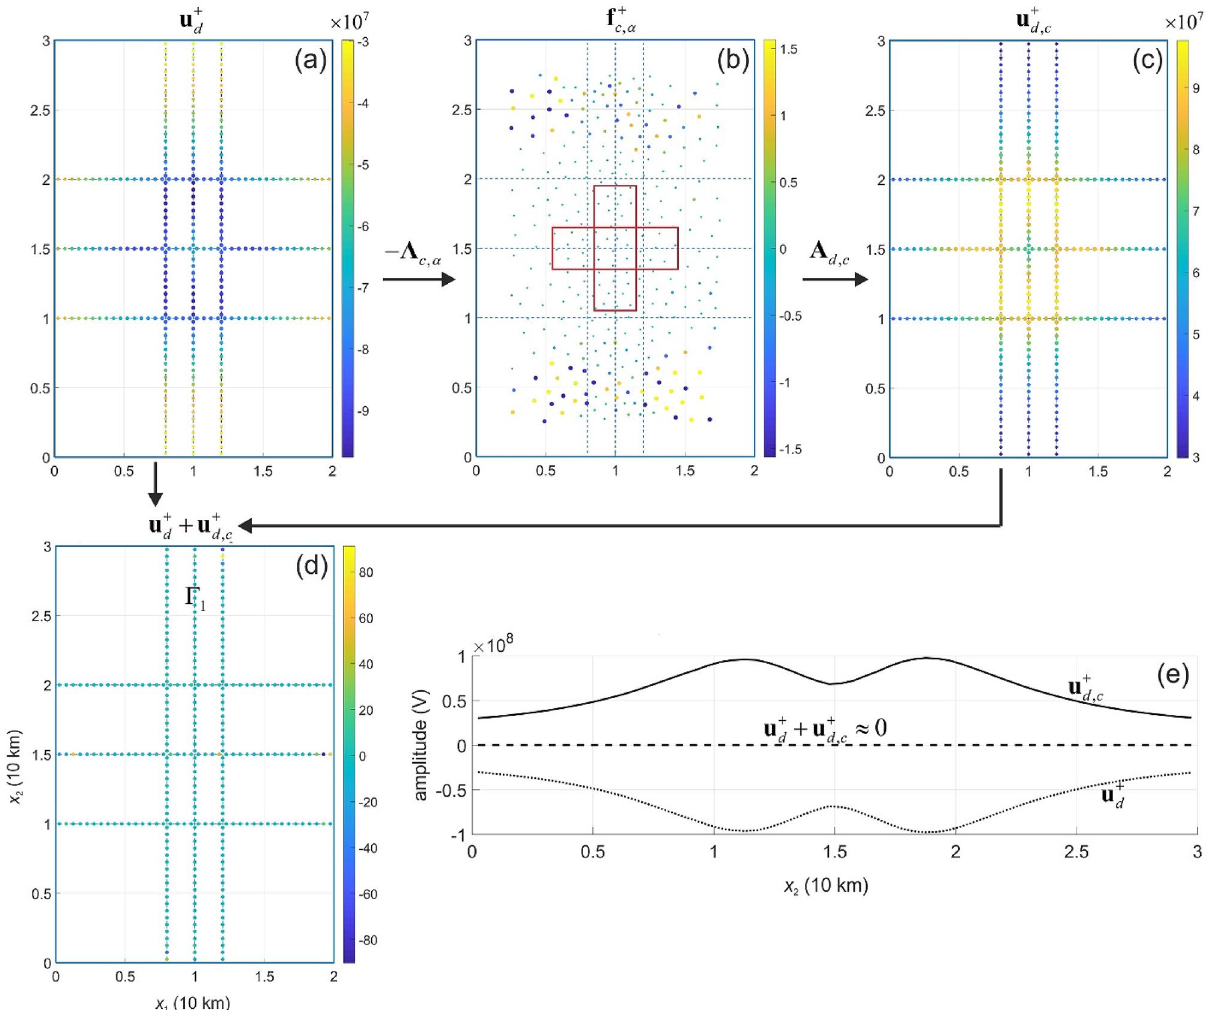
Figure 4. Active cloaking of the electric potential u + d on Ŵ ( a ) generated by the current source density f + . Using Eq. (13) the cloaking devise is modelled by the current source density f + ( c ) leading to a significant reduction (almost cancellation) of the electric potential signal on Ŵ ( d ). Panel ( e ) demonstrates the cancellation of the signal u + d + u + d , c (see dashed line) on the middle path (line Ŵ 1 : { x ∈ (cid:31) u : x 1 = 0 km ; x 3 = 0.5 km } ⊂ Ŵ ) of the synthetic measurement